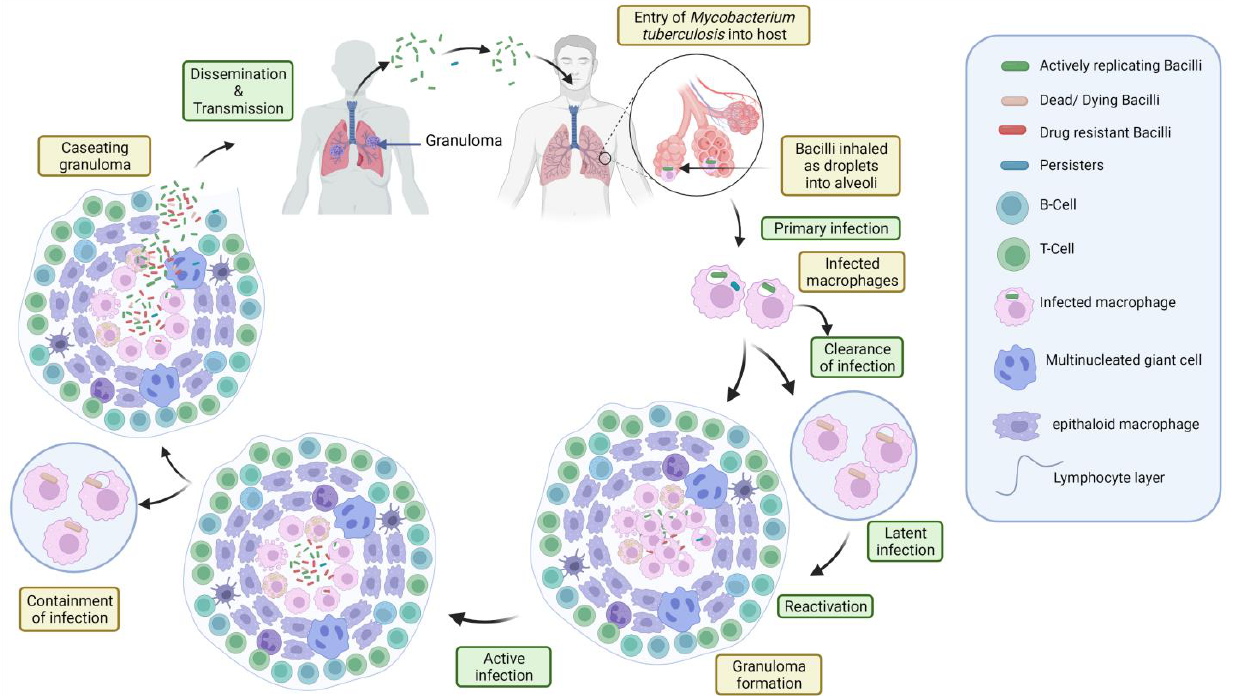
Figure 2. Various stages of TB progression (Created with BioRender.com).